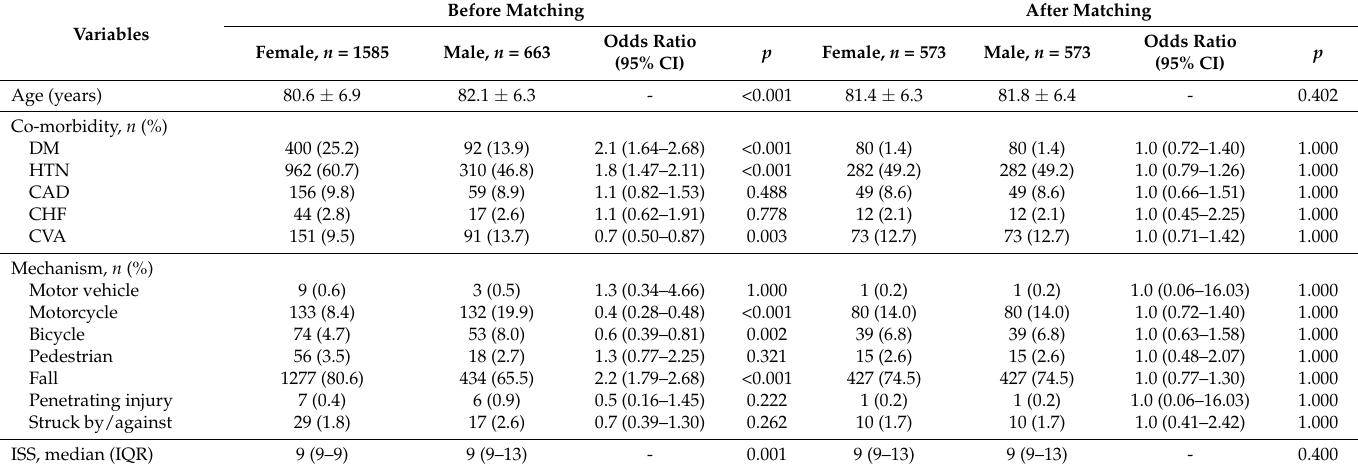
Table 2. Covariates of male and female patients with high-risk OSTA scores before and after propensity-score matching analyses (1:1 matching via greedy method).